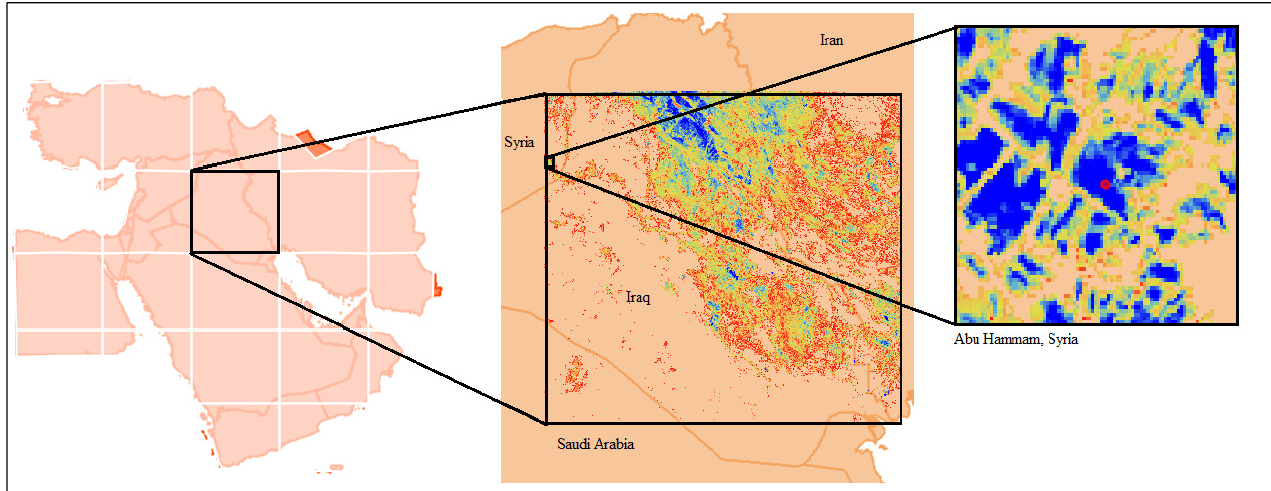
Figure 2. Schematic illustration of how the whole area of the Middle East is segmented into 22 pro- cessing tiles. For each tile, a collection of Landsat images is acquired and processed. The middle panel shows the NDVI at a specific time. A small region (2 × 2 km 2 area) in Abu Hammam, Syria, is zoomed in to show how Landsat portrays medium-sized wheat crops in this region.